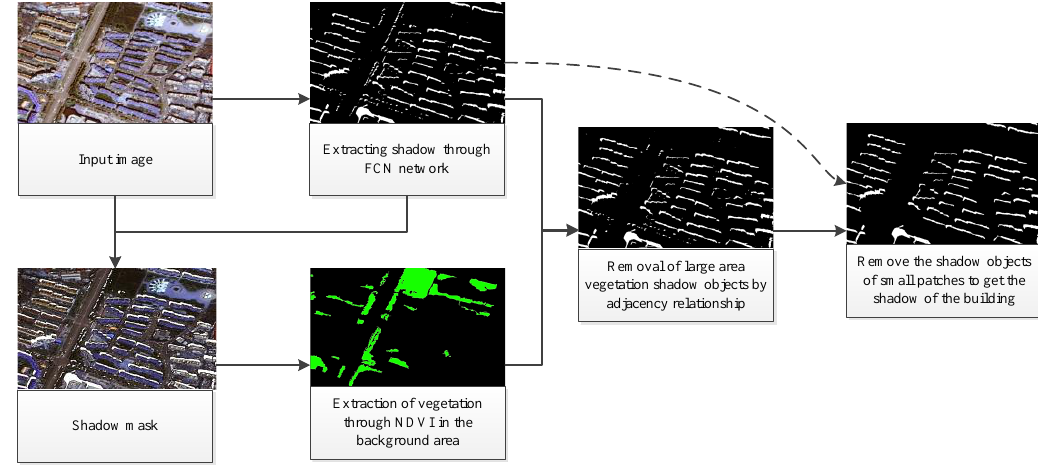
Figure 5. The procedure of building shadow extraction